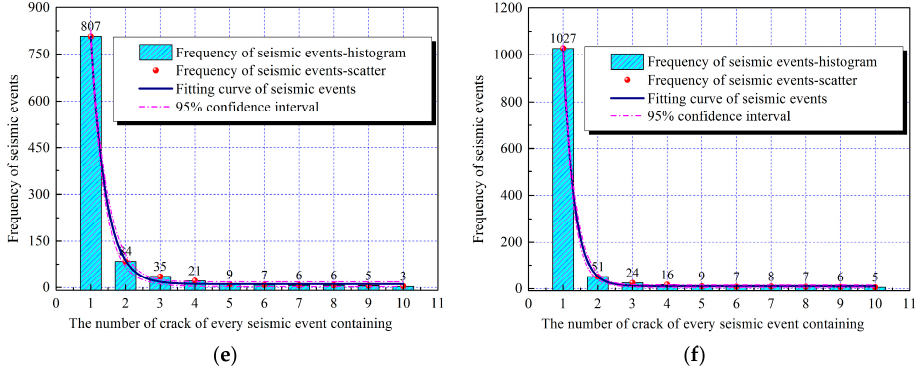
Figure 19. Relationship between the frequency of seismic events and the number of cracks of every seismic event containing different injection sites: ( a ) L if = 10 m; ( b ) L if = 20 m; ( c ) L if = 30 m; ( d ) L if = 40 m; ( e ) L if = 50 m; and ( f ) L if = 60 m.